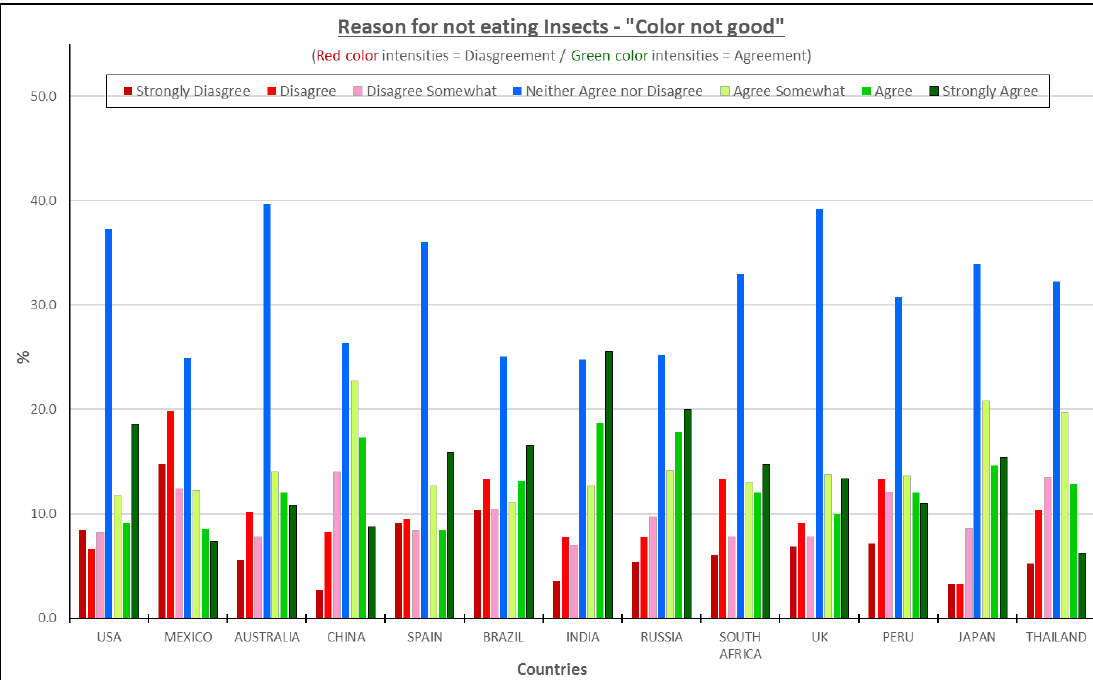
Figure 9. The reasons for not eating insect products—“Color would not be good”.